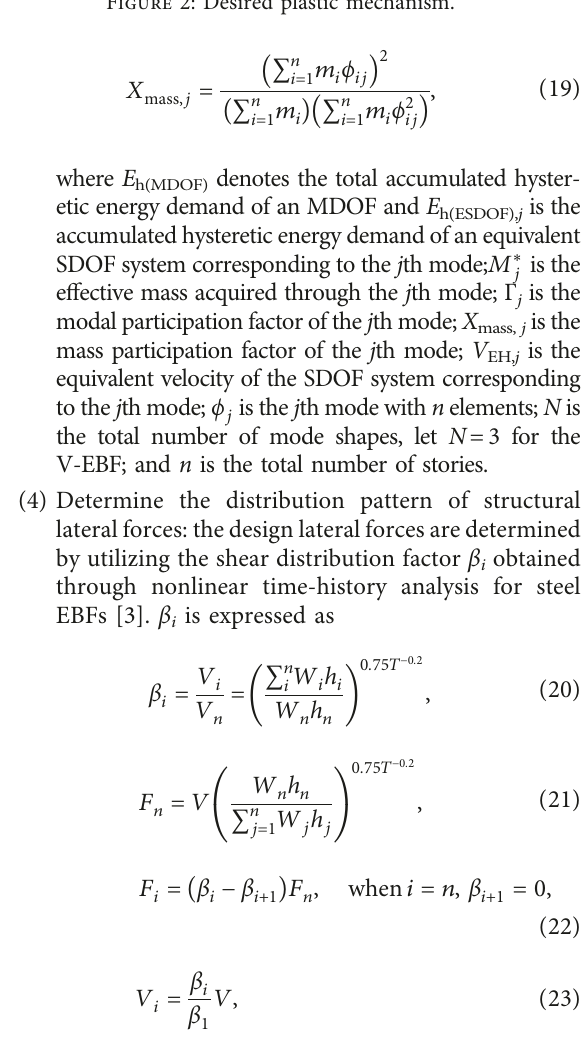
Figure 2: Desired plastic